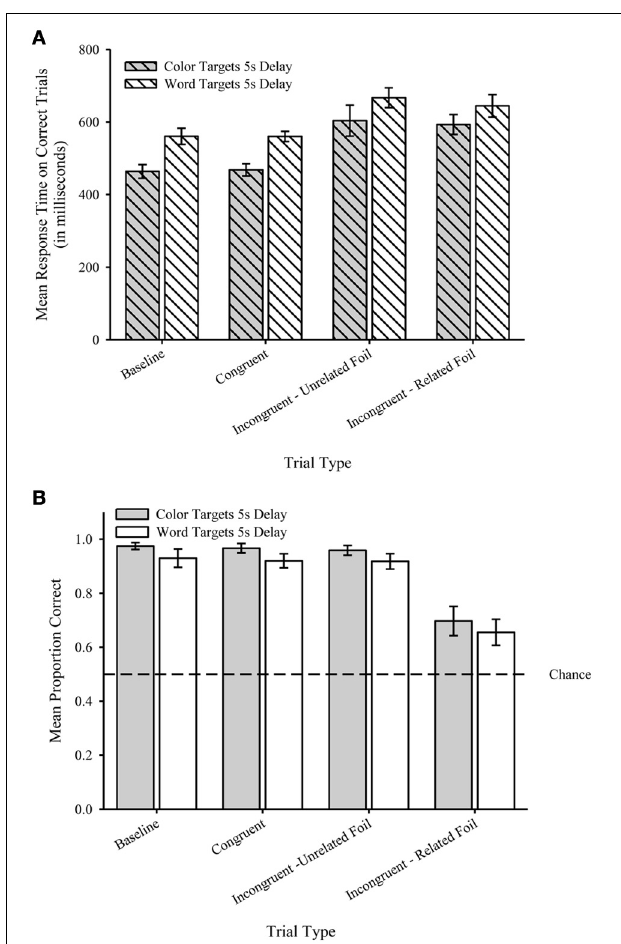
FIGURE 2 | (A) Mean response time during Testing (in milliseconds) plotted by Trial Type for Color Targets (filled bars) the Word Targets (unfilled bars) for Experiment 1. (B) Mean proportion correct during Testing plotted by Trial Type for Color Targets (filled bars) the Word Targets (unfilled bars) for Experiment 1. Dashed line represents chance performance (0.5). Error bars represent standard errors of the